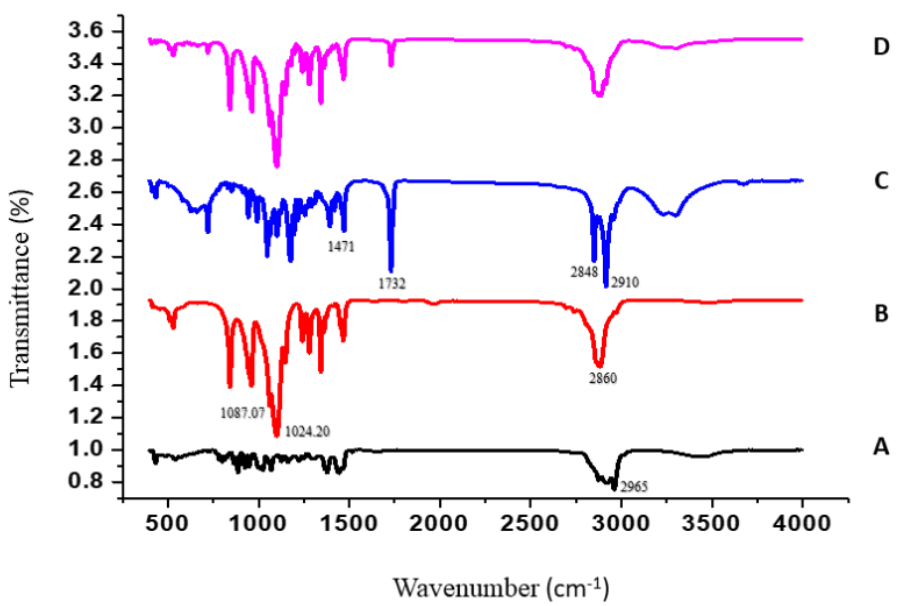
Figure 4. The FTIR spectra of TTO ( A ), P188 ( B ), GMS ( C ), and TTO-SLN1 ( D ).